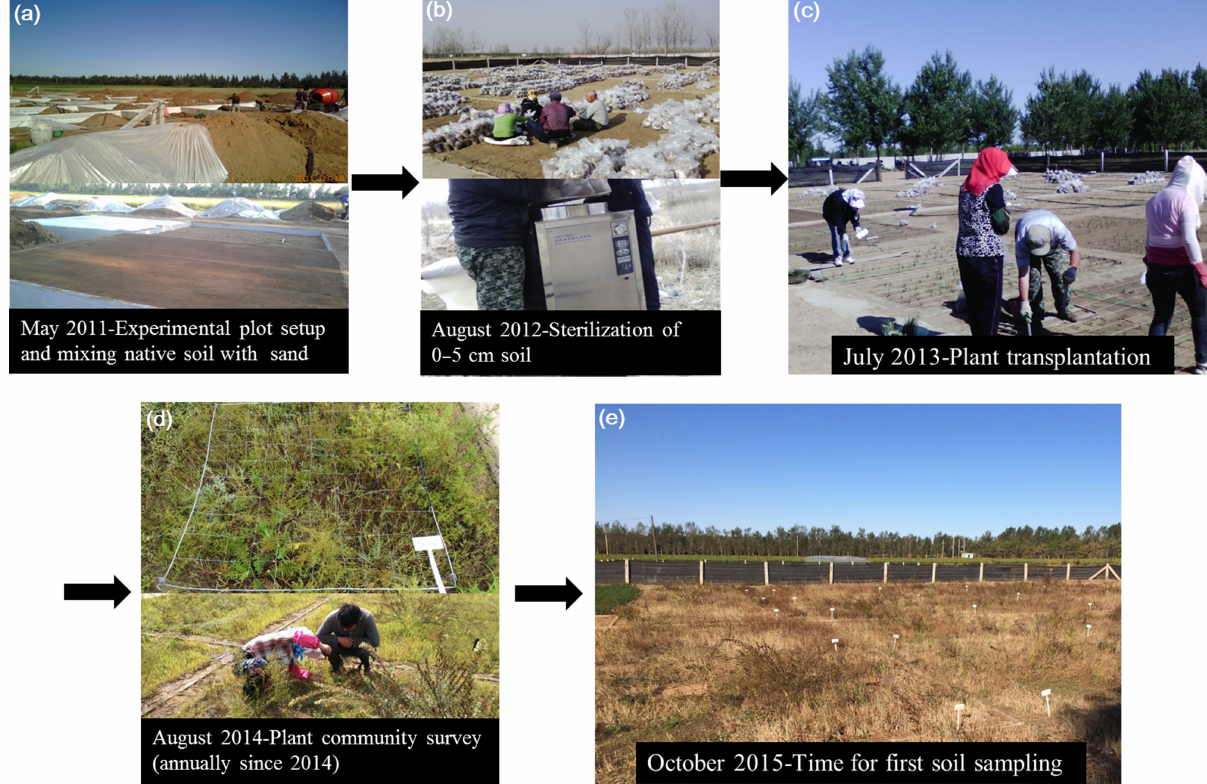
Figure 1. Overview of field experimentation with photos taken at various stages of the